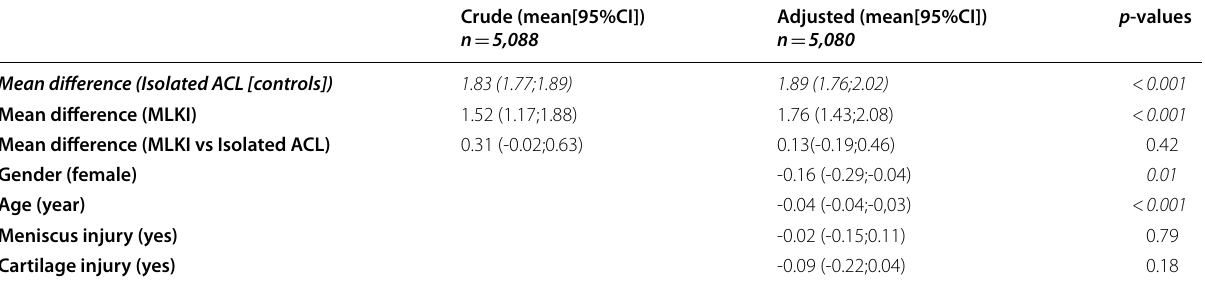
Regression model adjusted for gender, age, meniscus and cartilage injury. Data presented as mean (95%CI). p -values < 0.05 indicates if the variable influence on the adjusted mean